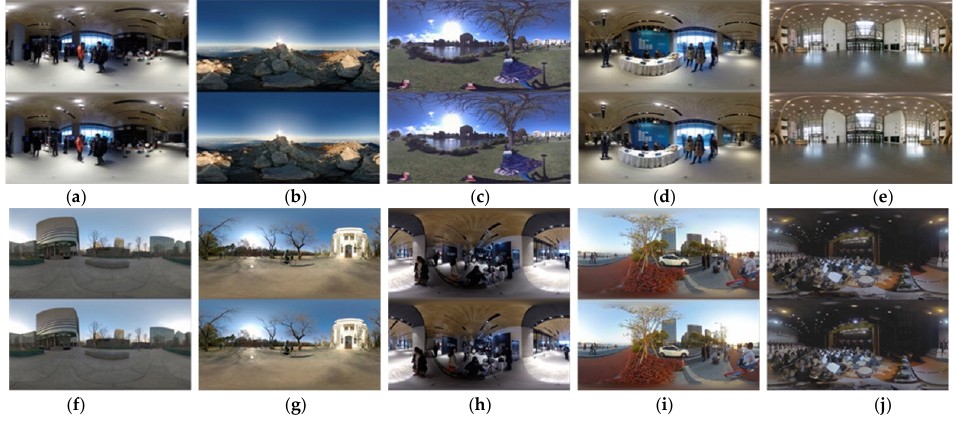
Figure 8. ( a – j ) Ten scenes in the HSOID database. Table 5. Quality factors of nine encoding distortion levels.